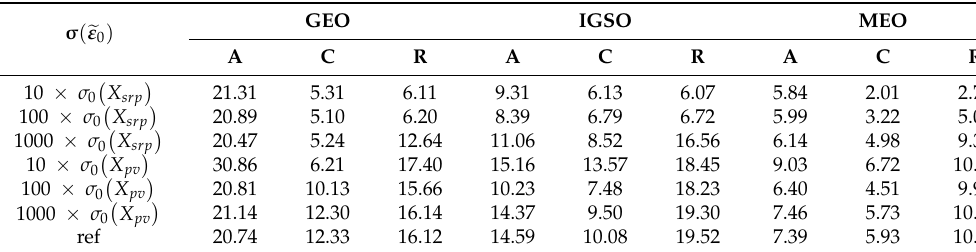
Table 8. The average convergence time of the filter orbit using different a priori STD when the BRDC product is used as the initial orbit. Unit [hour]. For the GEO satellites, the convergence criteria adopted in our study are 100 cm in the along-track, and 80 cm in the cross-track and radial direction. For the IGSO and MEO satellites, the criteria are 60 cm in three directions.